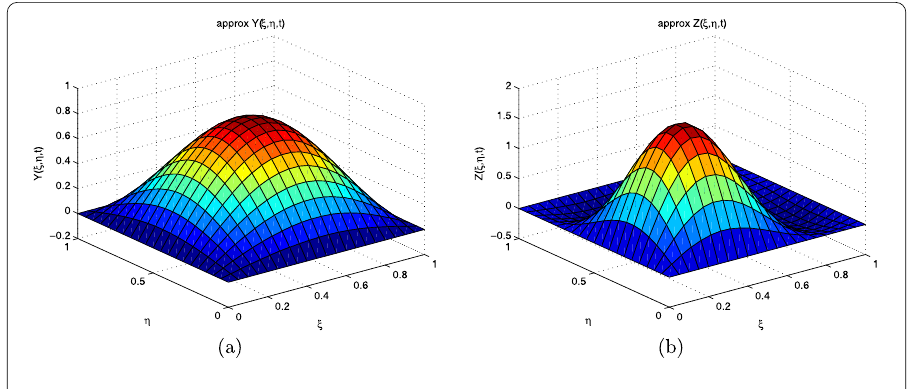
Figure 7 Solution profile of Example 8 at T = 0.01, N = 400, Re = 1, and dt = 0.0001